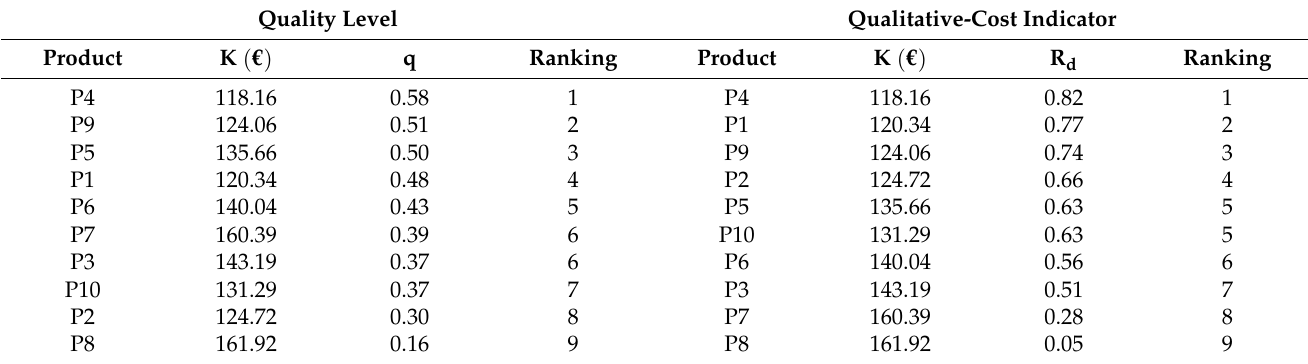
Table 12. Comparison of rankings of quality level and qualitative-cost indicator for photovoltaic panels. Quality